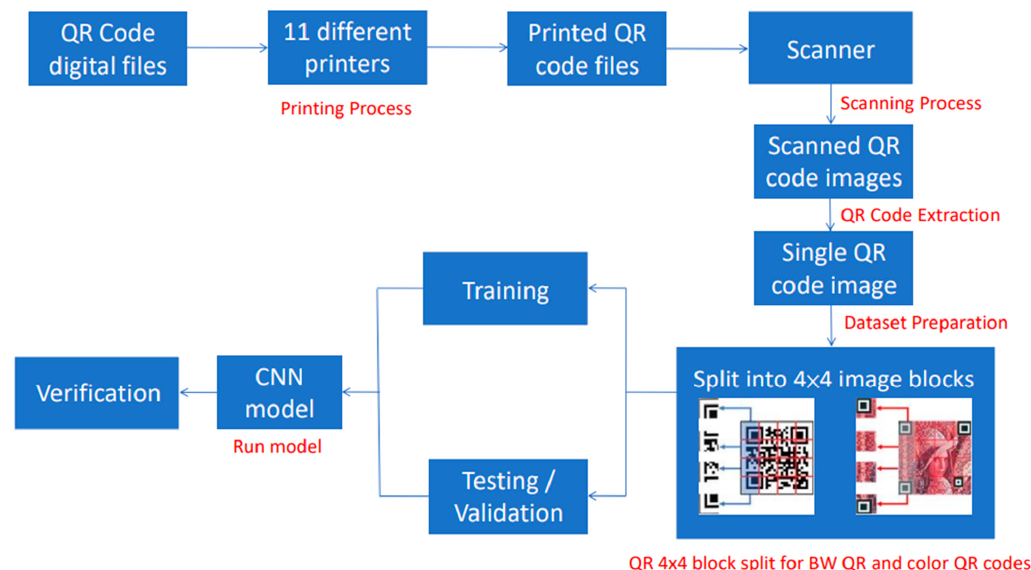
Figure 5. Proposed method’s process flowchart.